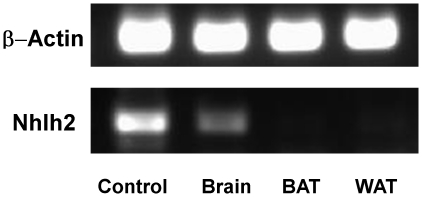
Nhlh2 expression WAT, Hypothalamus and BAT.Ethidium bromide-stained agarose gel showing PCR results following a 40-cycle amplification of mouse genomic DNA (control) or RNA from hypothalamus (Brain), white adipose (WAT), and brown adipose (BAT). β-actin expression was used as a loading control.